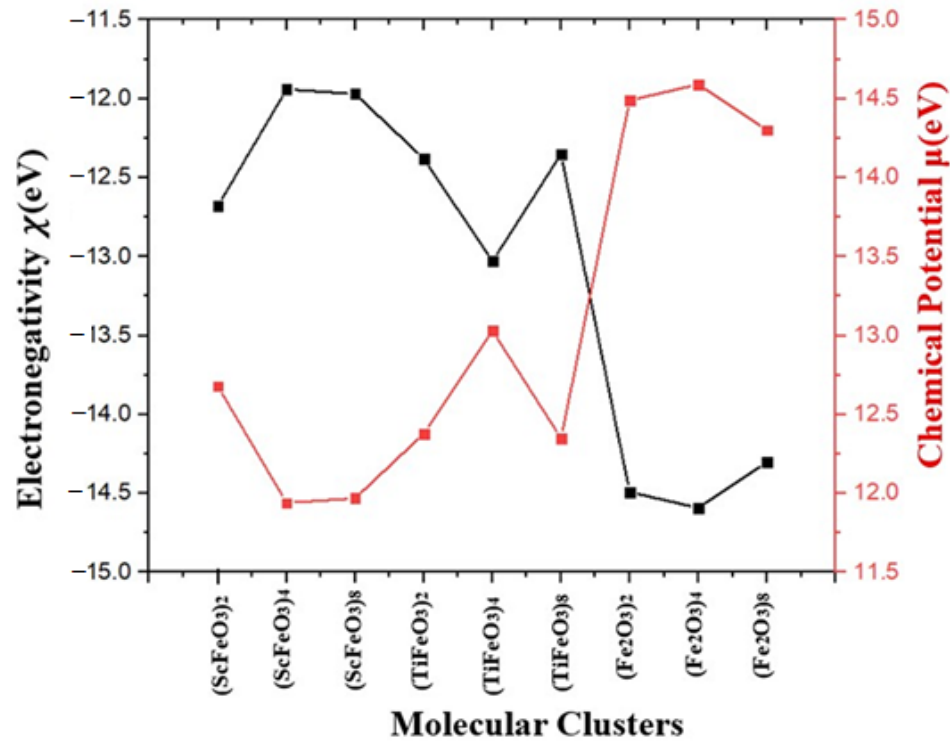
Figure 4. The computed values of electronegativity and chemical potential for (TMFeO (cid:2871) ) (cid:2934) molecular clusters where x = 2, 4, 8 and TM = Sc, Ti, and Fe.